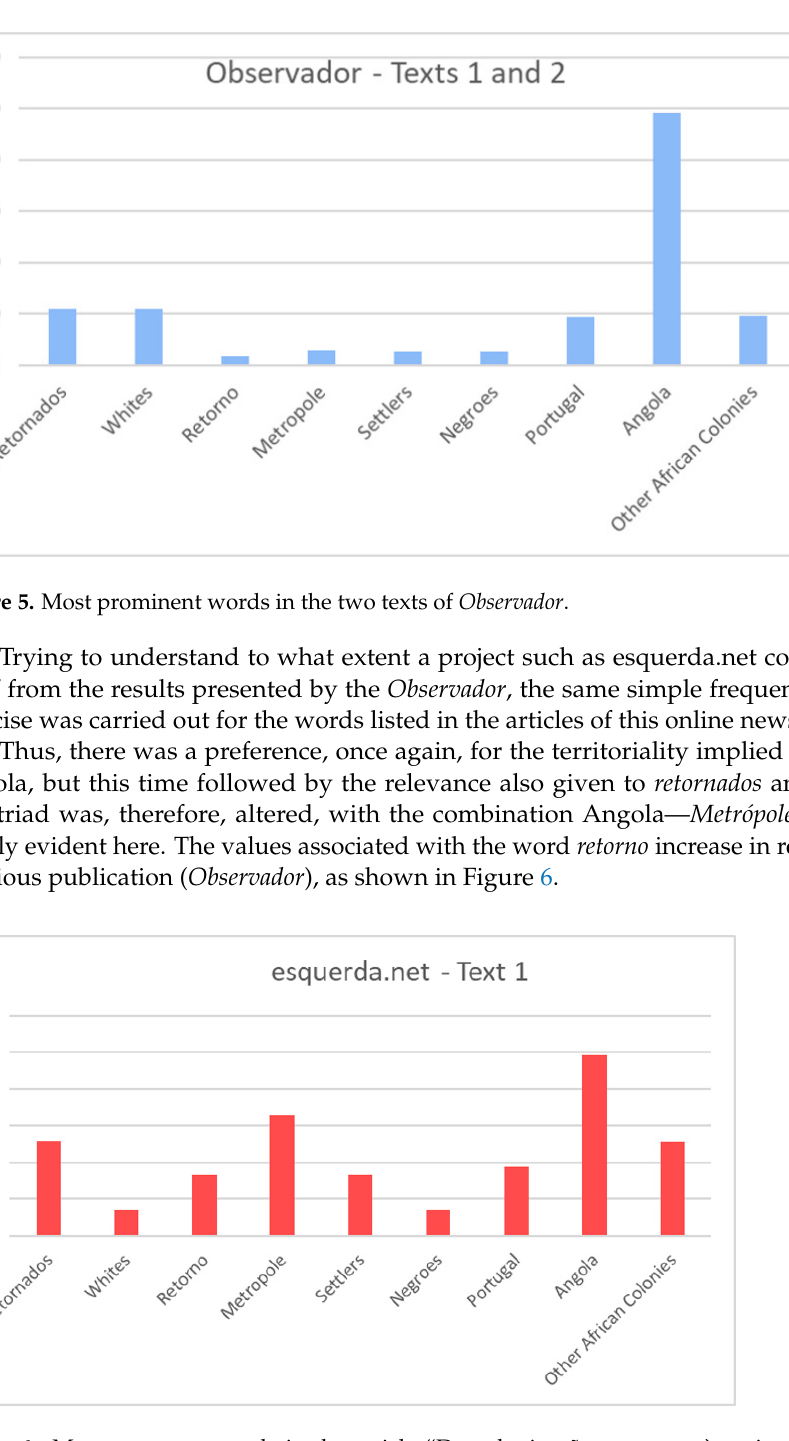
Figure 6. Most recurrent words in the article “Descolonização e retorno à antiga metrópole: a memória difícil do fim do império”. Scheme 2019. [21].